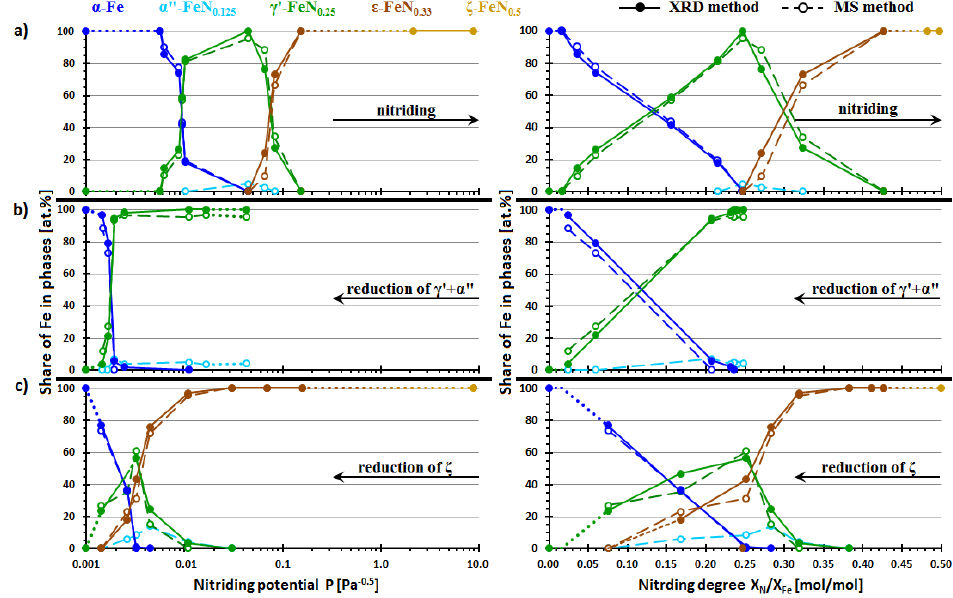
Figure 4. The dependence of the share of iron in the phases present in the samples on nitriding potential and nitriding degree for: the nitriding process of nanocrystalline iron ( a ), the reduction reaction of the mixture of nanocrystalline iron nitrides γ’ -FeN 0.25 and α” -FeN 0.125 ( b ), and the reduction of nanocrystalline iron nitride ζ -FeN 0.5 ( c ).